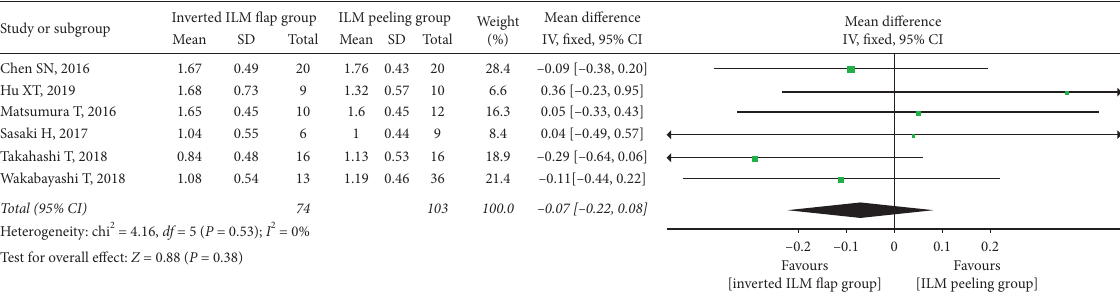
Figure 5: Forest plot comparing preoperative BCVA between inverted ILM flap and ILM peeling groups. BCVA � best-corrected visual acuity, ILM � internal limiting membrane.